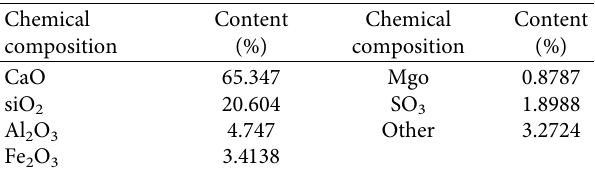
Figure 1: Micromorphology of ceramic powder. (a) AT13. (b) AT40. (c) nAT13. (d) Nanoscale AT13. Table 2: Cement chemical composition (mass fraction). Table 4: Chemical composition of fly ash (mass score).